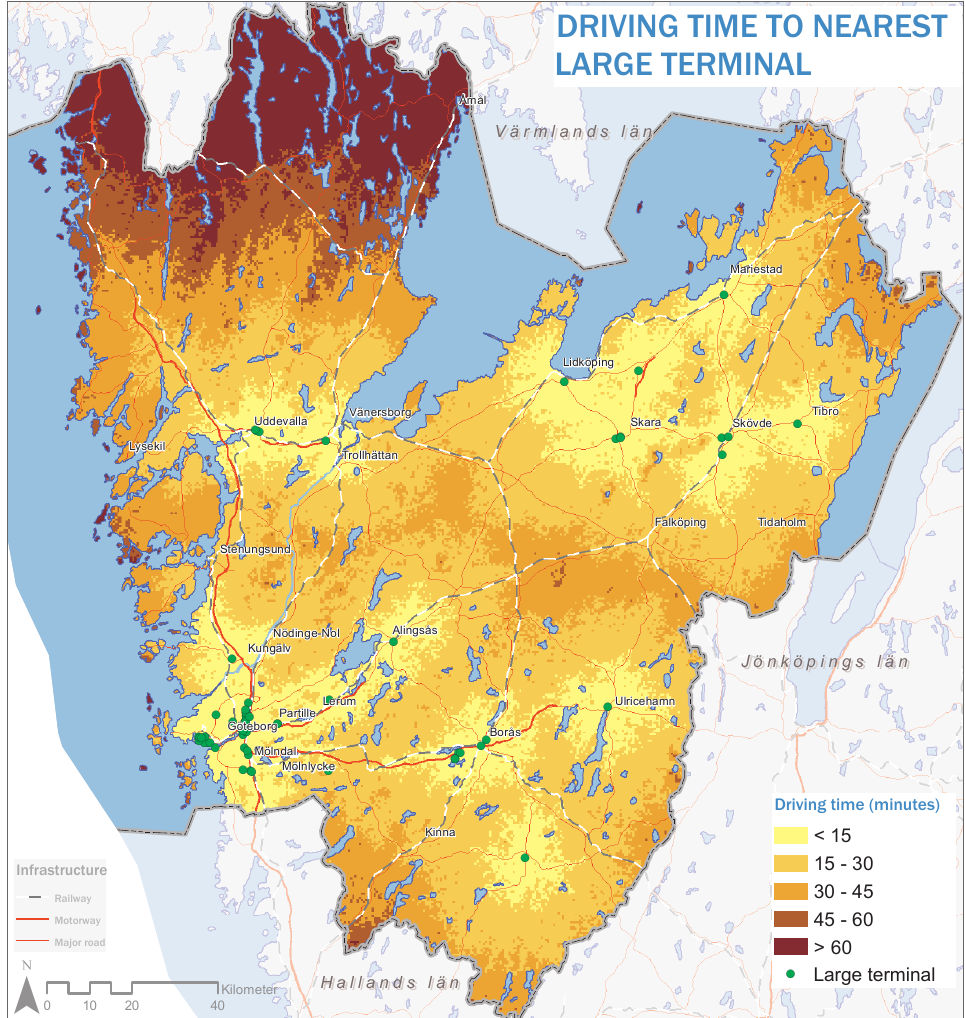
Figure 4: Accessibility in terms of driving time to the nearest large terminal, defined as having annual turnover exceeding SEK 100 million